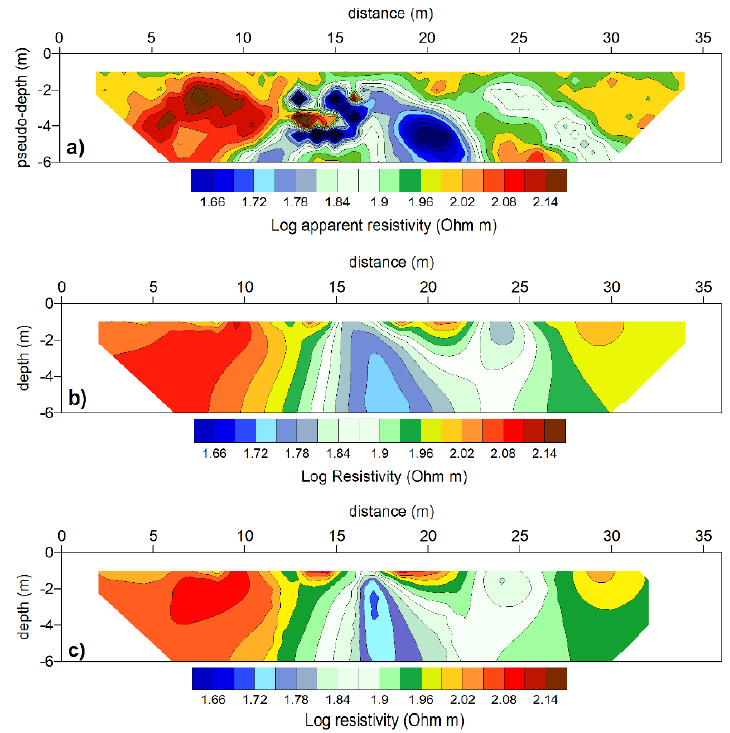
Figure 9. Pseudosection corresponding to the three-prism model in Figure 2a, corrupted by a 30% random noise in the left side portion ( a ); classical PERTI section ( b ); section resulting from the estimation of ρ m with a weighted best-fit procedure applied point by point to the resistivity values obtained by a sequential horizontal scanning ( c ).